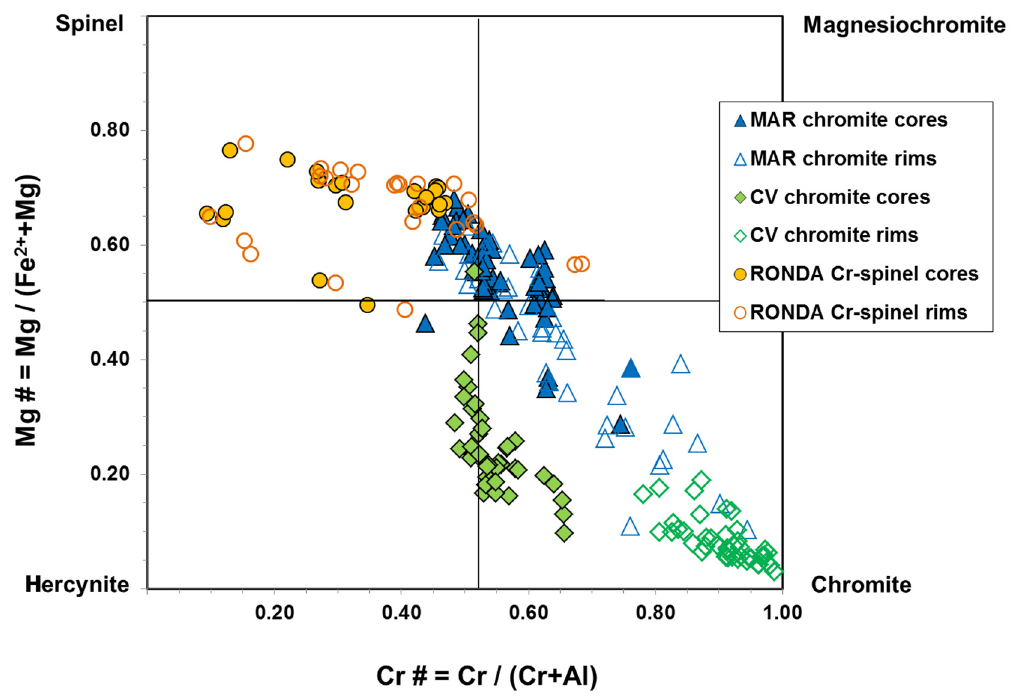
Figure 3. Mg# vs. Cr# plot of chromite cores and rims of the MAR, CV and Ronda samples.